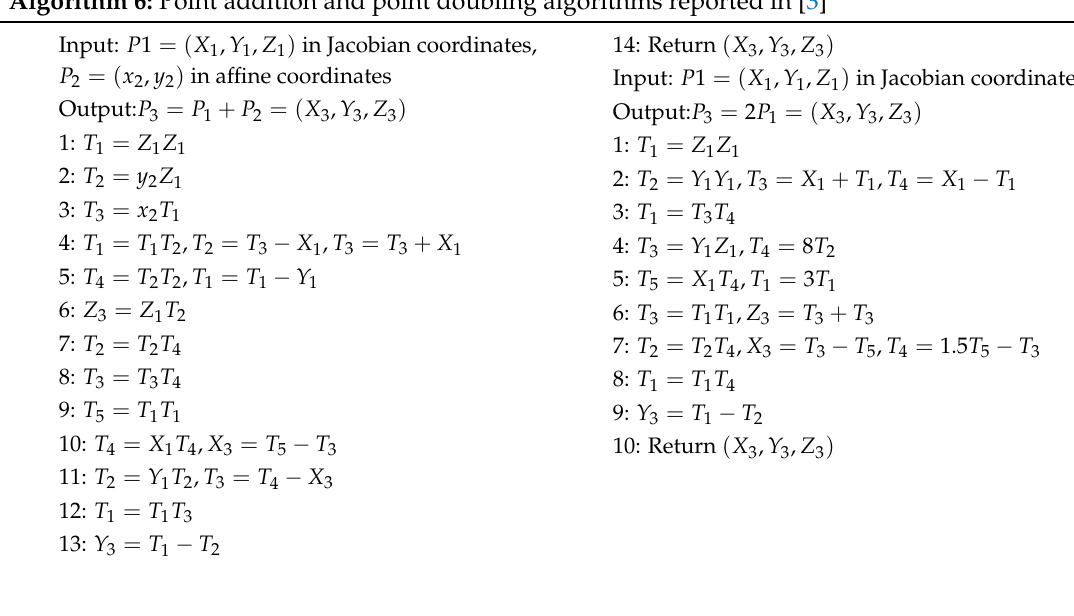
Algorithm 6: Point addition and point doubling algorithms reported in [3]